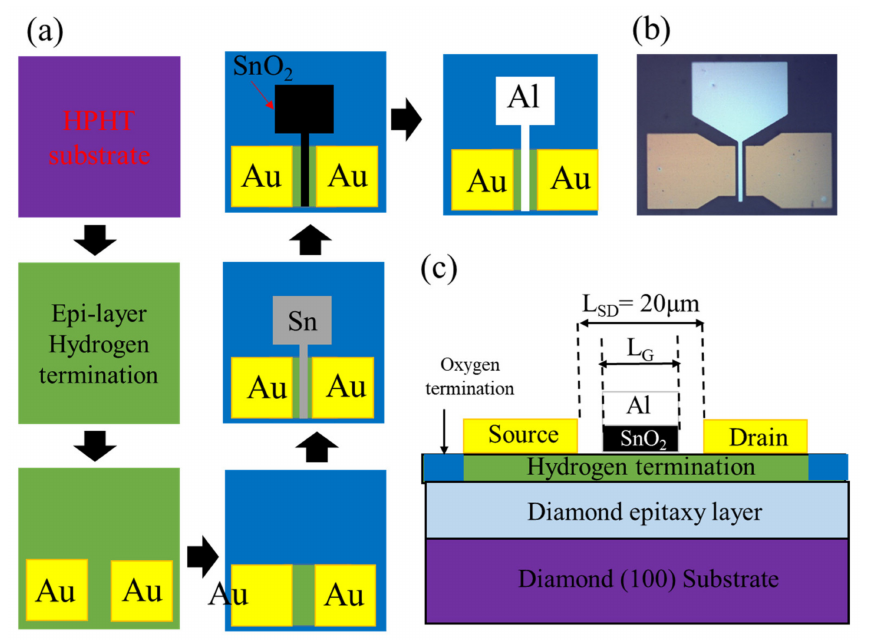
Figure 1. ( a ) Schematic of H-diamond FET fabrication process; ( b ) Optical photo of H-diamond FET. ( c ) Cross-section schematic of the